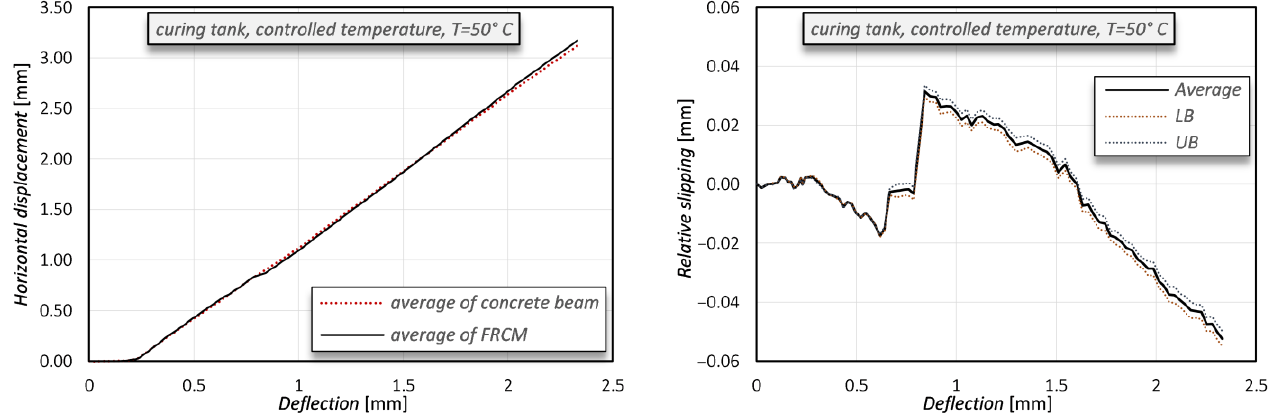
Figure 16. Comparison of average horizontal displacements measured on the concrete beam (black line) and on the FRCM (dotted red line) ( left ) and relative slipping between the concrete beam and the FRCM (UB = upper bound; LB = lower bound) ( right ).